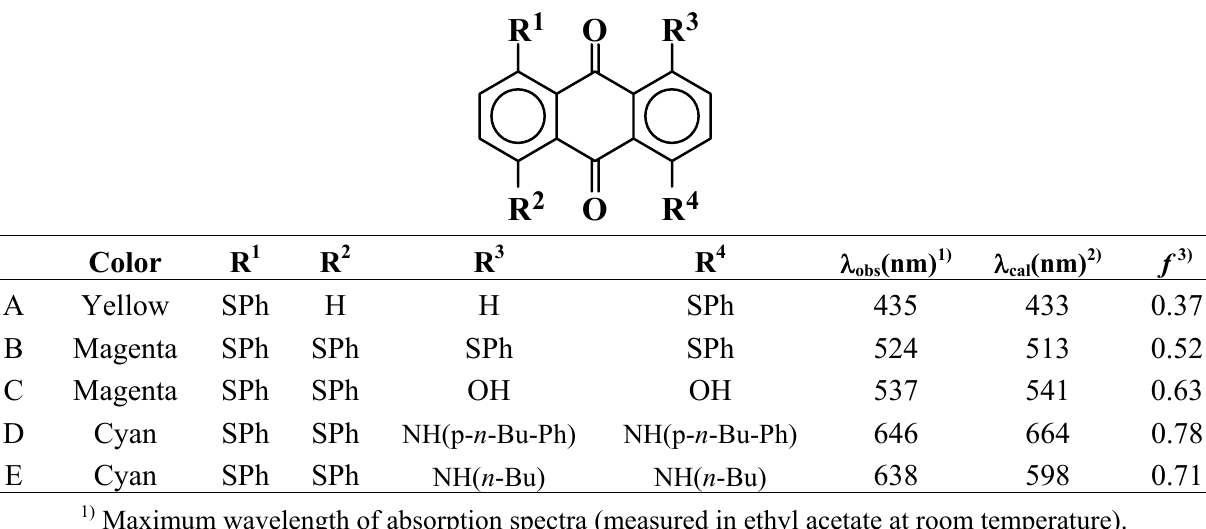
Table 1. Extracted molecular structures of yellow, magenta and cyan dyes for the three- layer GH-LCDs from the viewpoint of absorption spectra.